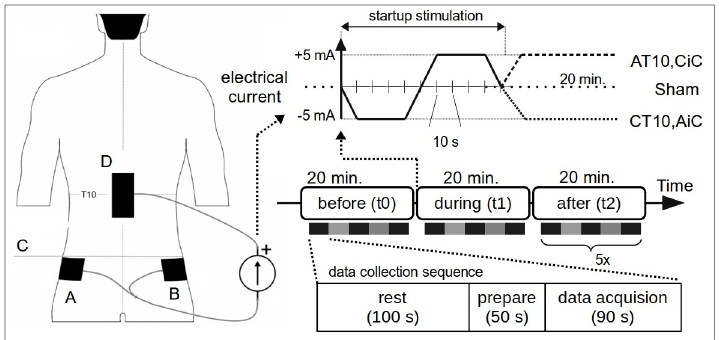
Fig 1. Electrode placement and experimental protocol. Back torso illustration on the left: One electrode (10x5 cm 2 ) was placed over T10 (D) and two electrodes (10x5 cm 2 ) on the upper edge (C) of the iliac crests (A and B). The three protocols were composed of a startup stimulation (upper right plot) consisting of a 5 mA 50-seconds stimulation with the electrode over the spinal cord configured as cathode followed by a 5 mA 50-seconds stimulation of opposite polarity. On each experimental day, 5 repetitions of a data collection sequence (resting in a chair for 100 seconds, 50 seconds to prepare and start the quiet standing task and 90 seconds of data acquisition, as shown by the bottom right scheme) were performed both before (t0), during (t1) and after (t2) the electrical stimulation protocol (center right scheme). During the electrical stimulation protocol (t1), after the startup stimulation, the stimulator was held either at +5 mA (AT10,Cic), -5mA (CT10,Cic) or turned off (Sham) for 20 minutes. The electrical slew rate was 0.5 mA/s. The electrical stimulator was turned off before (t0) and after (t2) the electrical stimulation